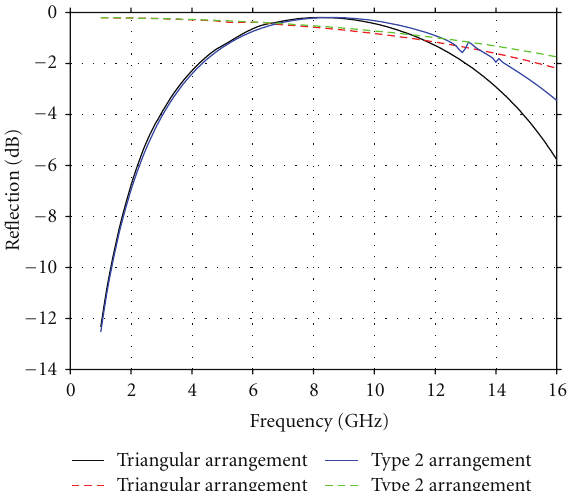
Figure 3: The reflection coe ffi cient for a normally incident wave with parallel/orthogonal polarization upon the structure given in Figure 2. The dimensions correspond to t = 1.5mm, d = 3.0mm, l d = 8.4 mm, b = 3.0 mm and s = 0.4mm, and ε r = 2.2. The reflection is compared with the performance of a gangbusters “type 2” polarizer combination. Solid lines correspond to the parallel polarization and dashed lines correspond to orthogonal polarization, for example, where the E -field is parallel with dipole